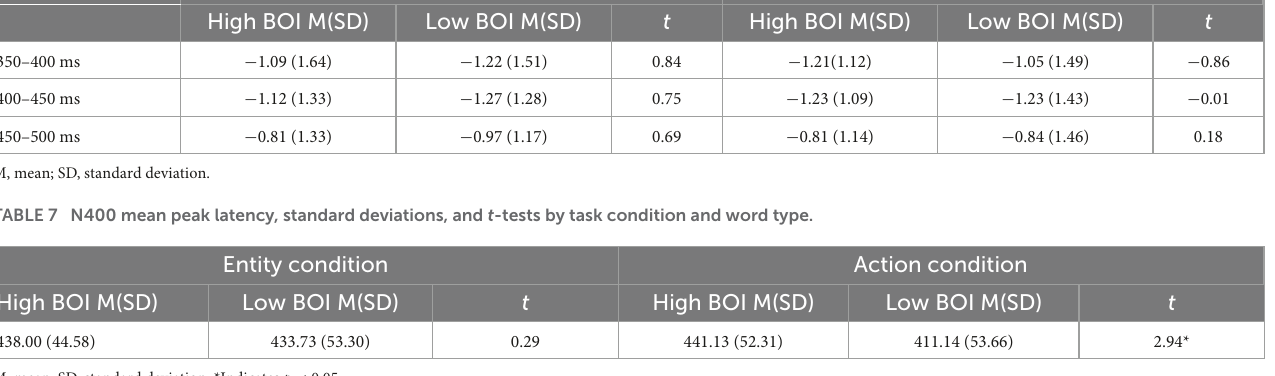
TABLE 6 N400 mean amplitude, standard deviations, and t -tests by task condition, word type, and time window. Time window Entity condition Action condition